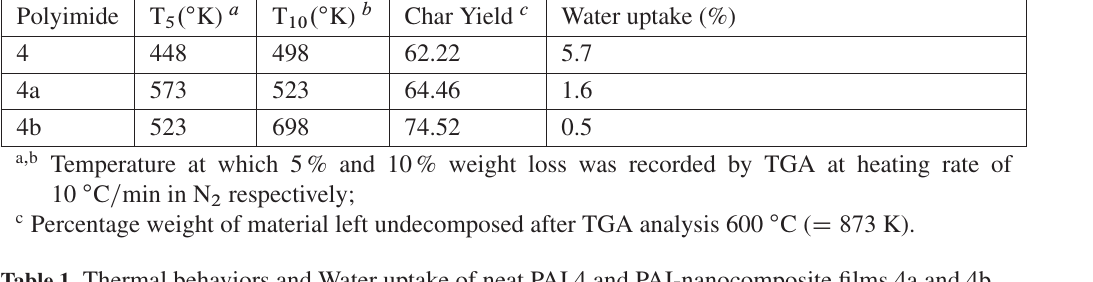
Table 1. Thermal behaviors and Water uptake of neat PAI 4 and PAI-nanocomposite films 4a and